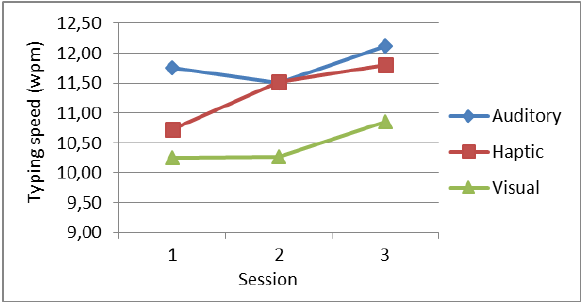
Figure 5. Typing speed in words per minute per